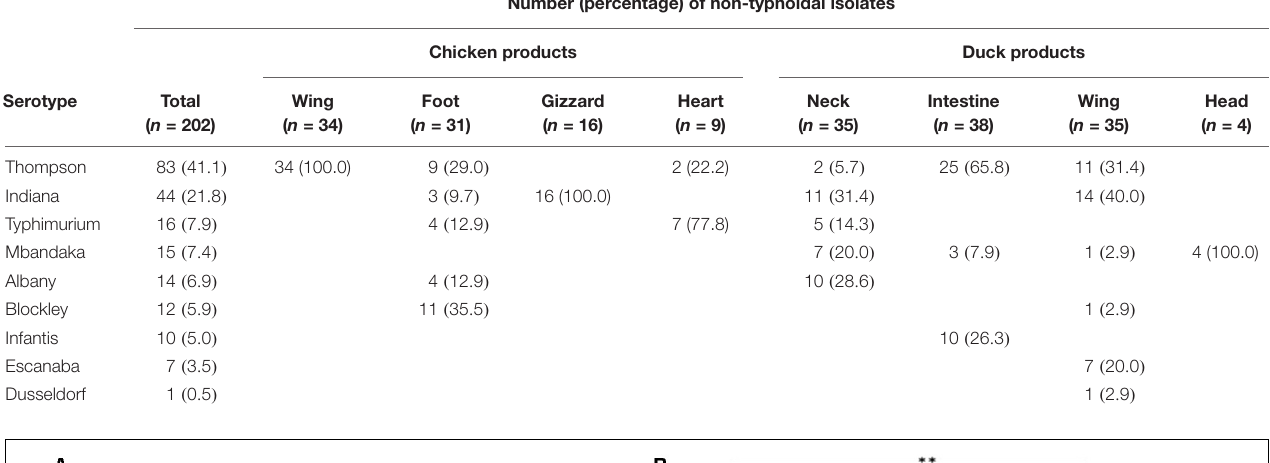
TABLE 4 | Distribution of non-typhoidal Salmonella serotypes identified in PRTEMs. Number (percentage) of non-typhoidal isolates Chicken products Duck products